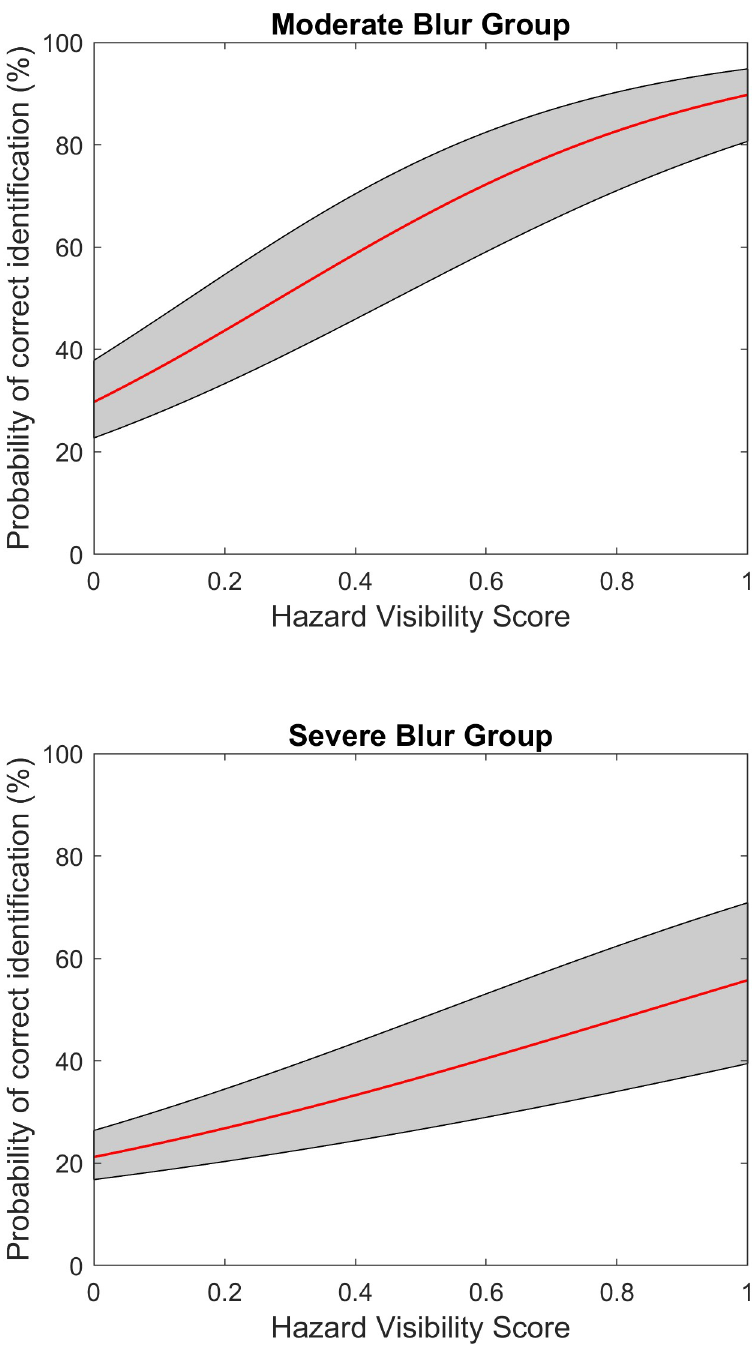
Fig 4. Logistic regression model of aggregated data from subjects viewing with artificial blur. Top: Moderate Blur (seven subjects), mean acuity 1.2 logMAR. Bottom: Severe Blur (seven subjects), mean acuity 1.6 logMAR. The red line shows the logistic regression function, transformed as shown in Eq 2. the gray area represents 95% confidence intervals.